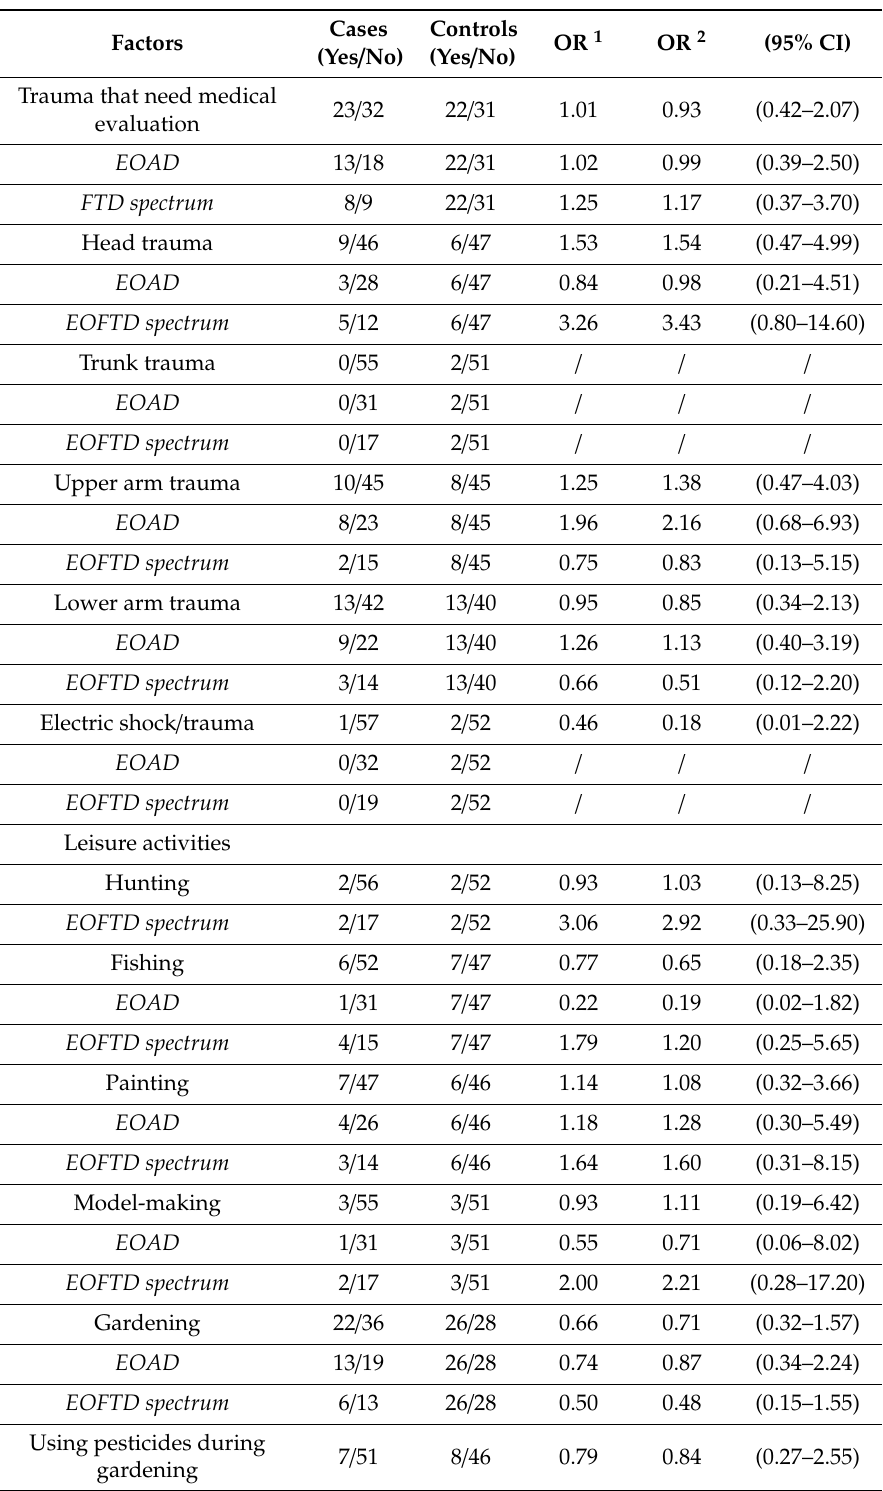
Table 5. Odds ratios (ORs) with 95% confidence intervals (CIs) for early-onset dementia (EOAD, early-onset Alzheimer’s dementia; EOFTD, early-onset frontotemporal dementia) according to trauma and leisure